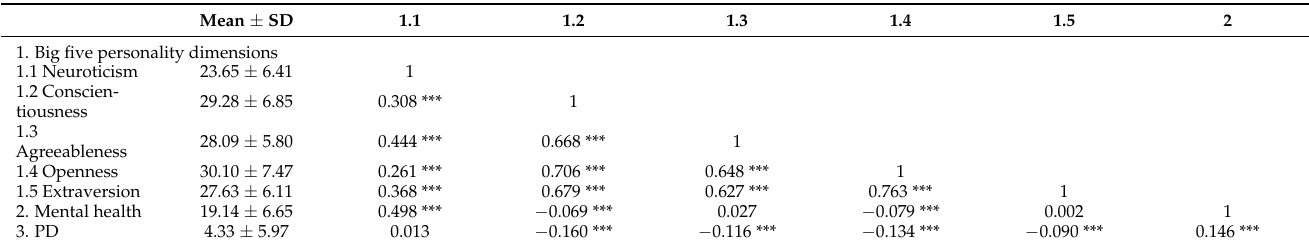
Table 2. Correlation coefficient matrix for parenting style differences, big five personality dimensions, and mental health (n = 2583).